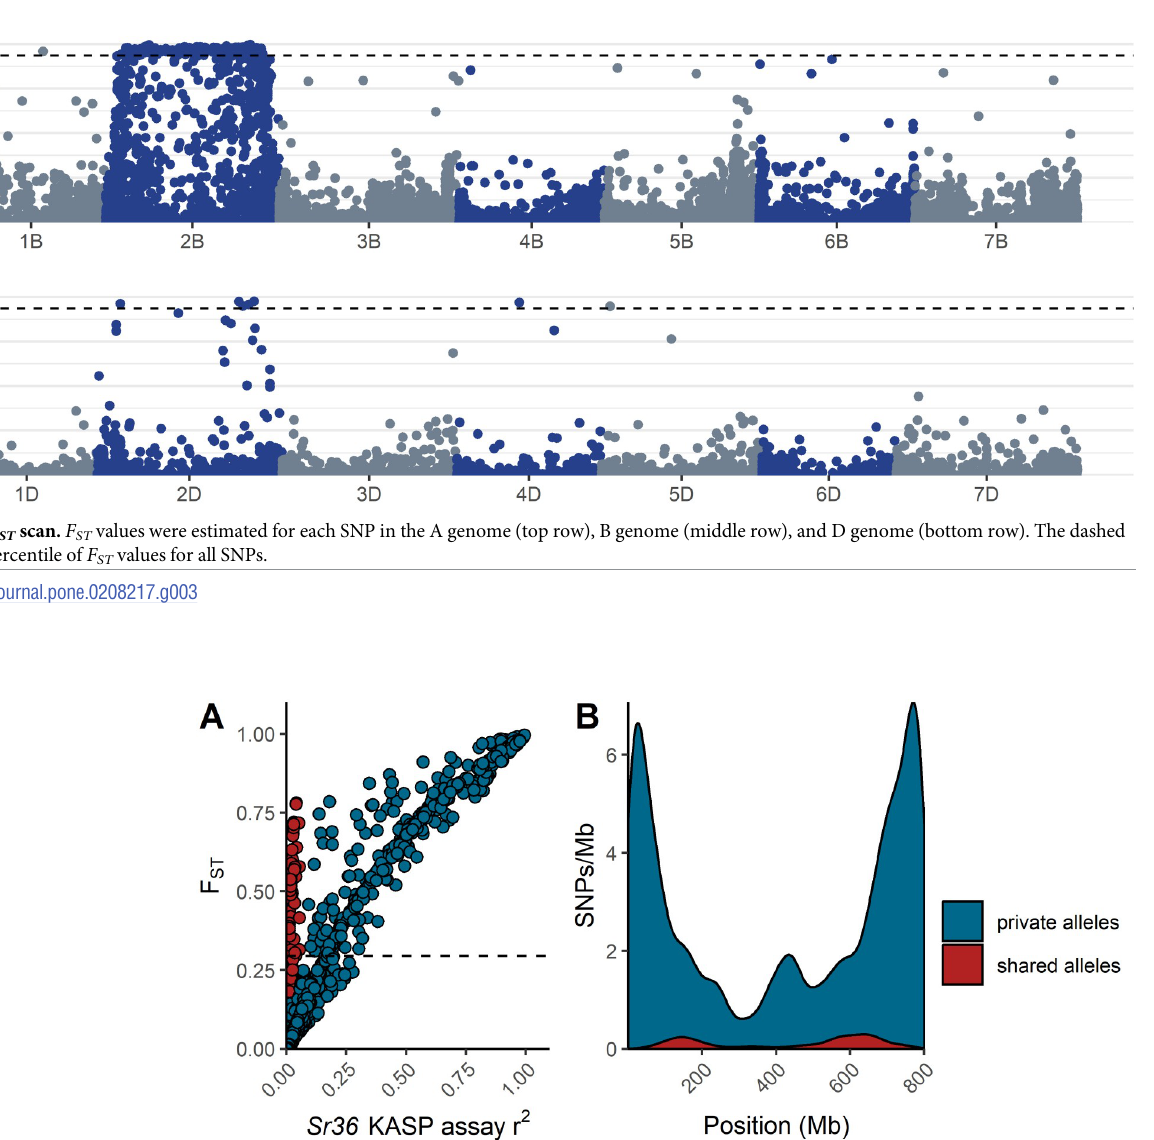
plotted against r 2 with the KASP ST shows no relationship with r 2 (red). ST